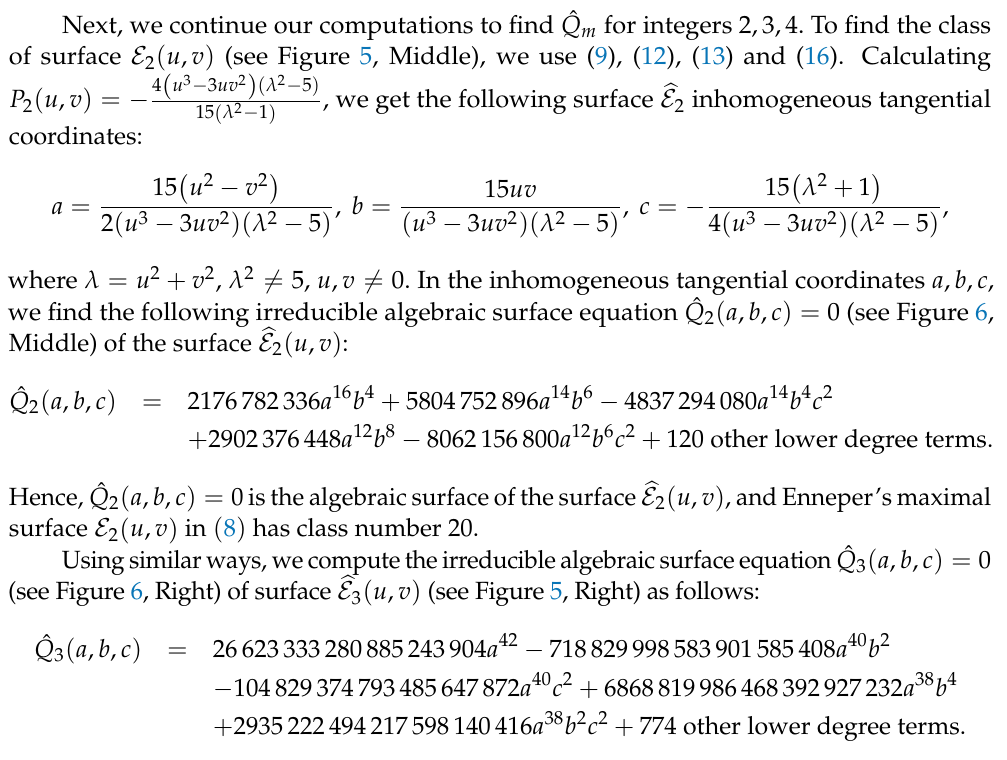
Figure 4. Top views of the Gauss maps of the surfaces E m = 1,2,3 ( u , v ) ( Left ): e 1 ( u , v ) , ( Middle ): e 2 ( u , v ) , ( Right ): e 3 ( u , v )